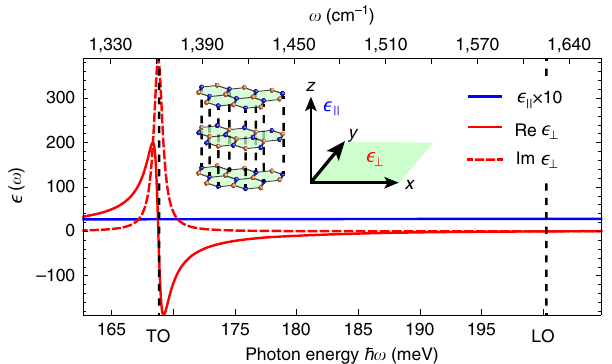
Fig. 2 Dielectric permittivity tensor of h-BN in the upper Reststrahlen band. Real ( solid red ) and imaginary ( dashed red ) parts of the principal components of ^ ϵ perpendicular to the h-BN optical axis. For the parallel component, the imaginary part is vanishingly small and only the real part is shown ( blue ). Inset illustrates the orientation of the tensor's principal axes with respect to the atomic sheets of h-BN. Left and right vertical dashed lines mark the TO and LO phonon frequencies, respectively